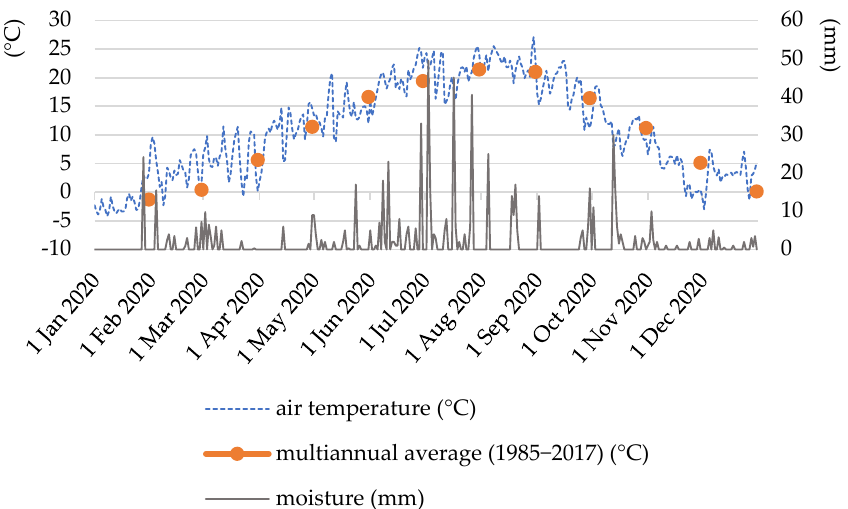
Figure 1. Precipitation and temperature values in 2020, Látókép Crop Production Experimental Site, University of Debrecen.